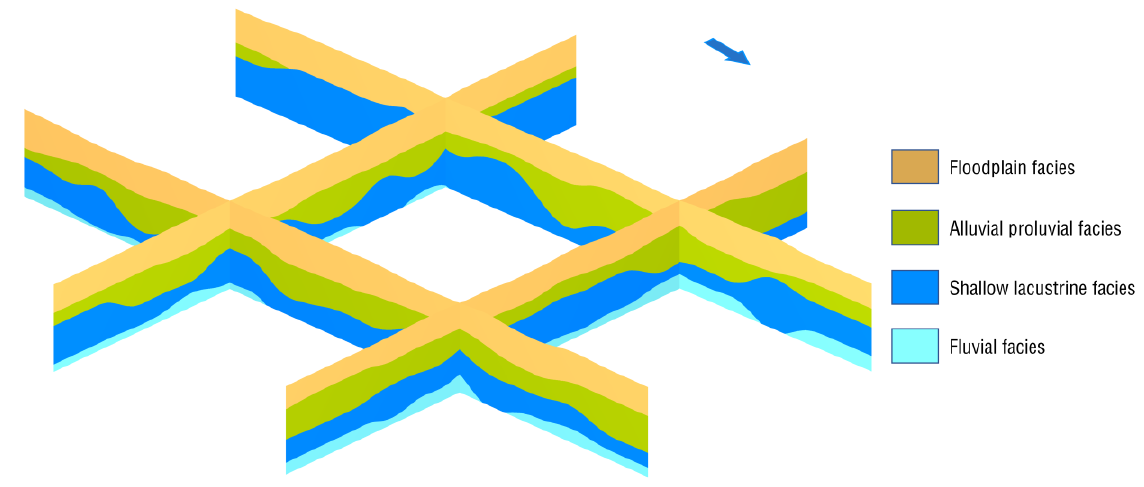
Figure 9. 3D profiles of the sedimentary stratigraphic structure model of the study area. Vertical exaggeration = 5×.